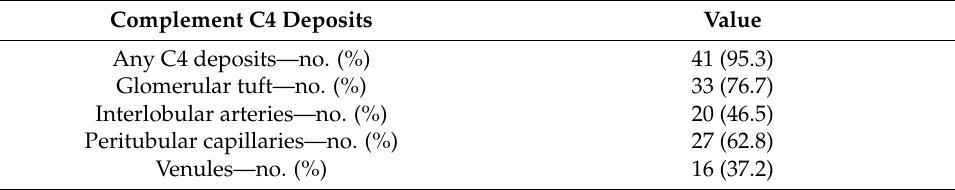
Table 2. Frequency of complement C4 deposits in the total cohort of ANCA-associated renal vasculitis. Complement C4 Deposits